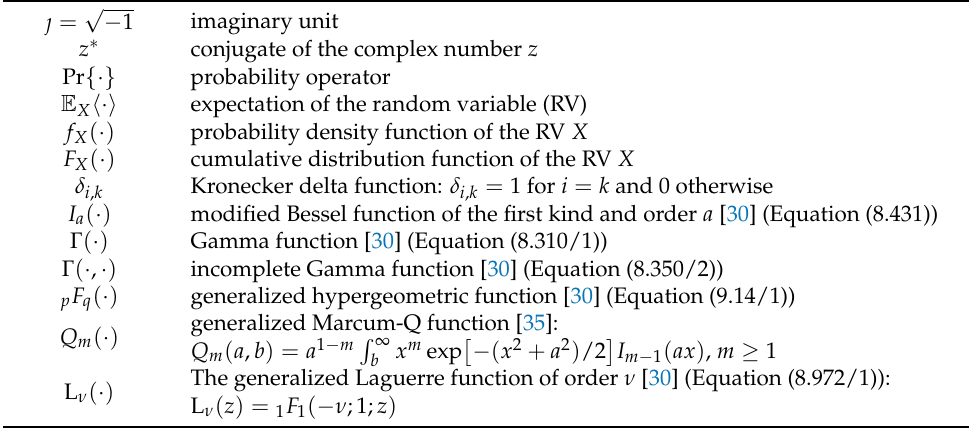
Table A1. Mathematical